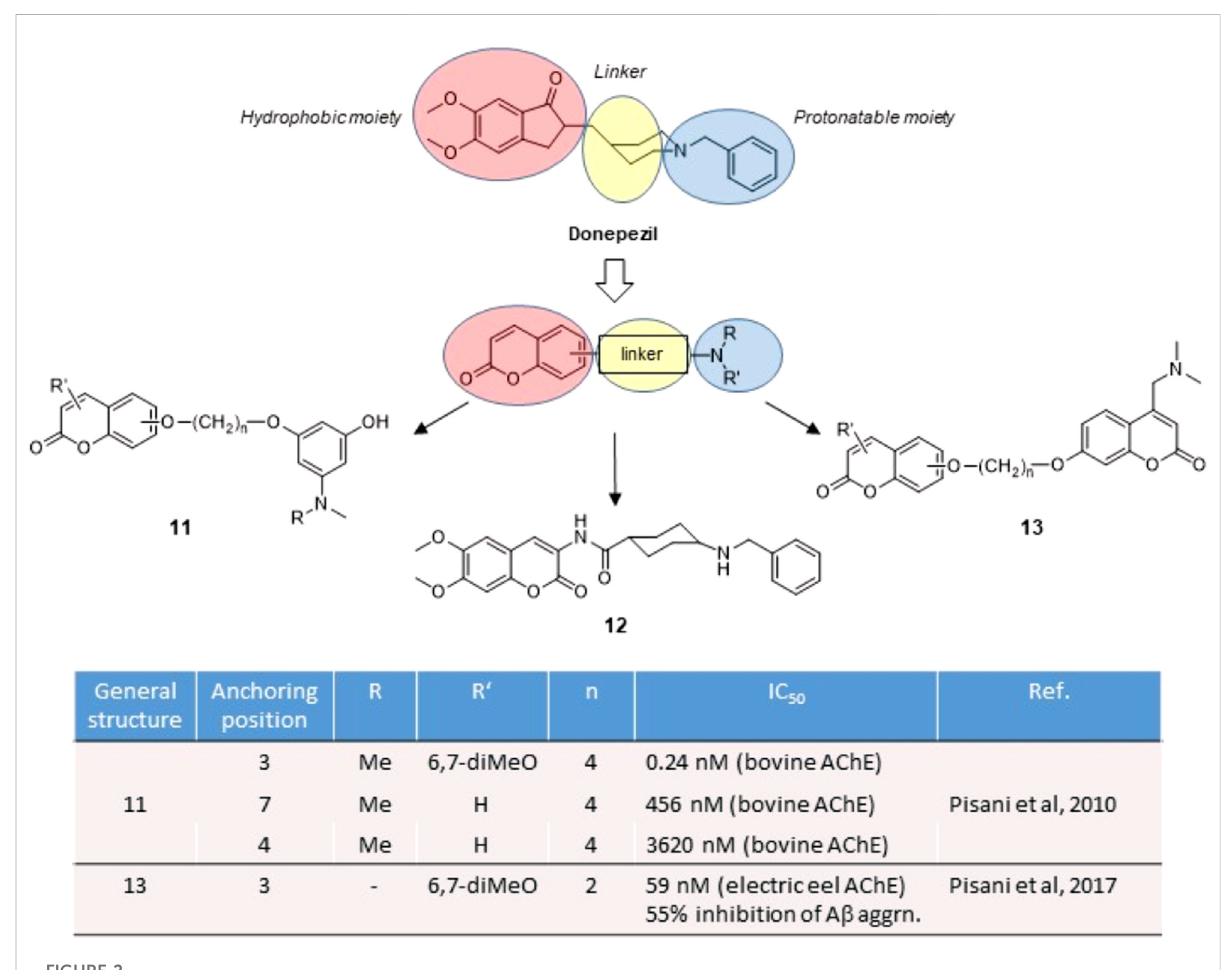
FIGURE 2 Rational design of AChE inhibitors by conjugative